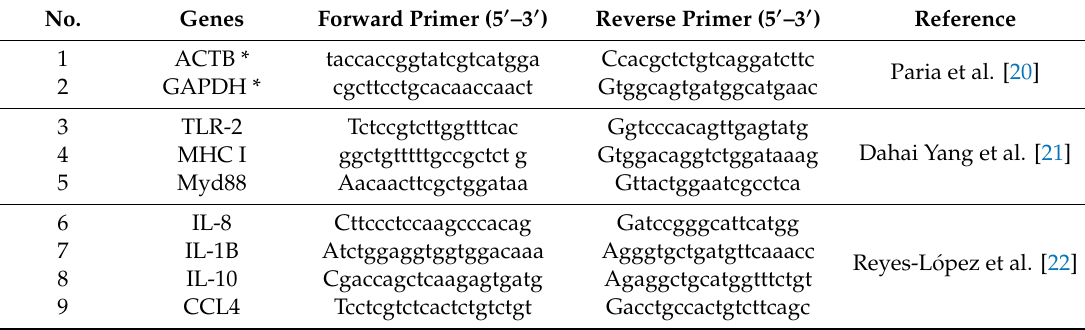
Table 3. List of genes for quantification of immune related genes in sea bass against